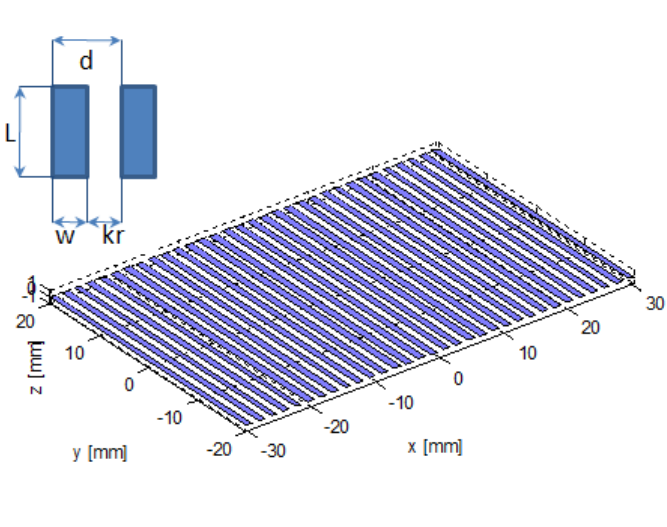
Figure 1. Proposed array